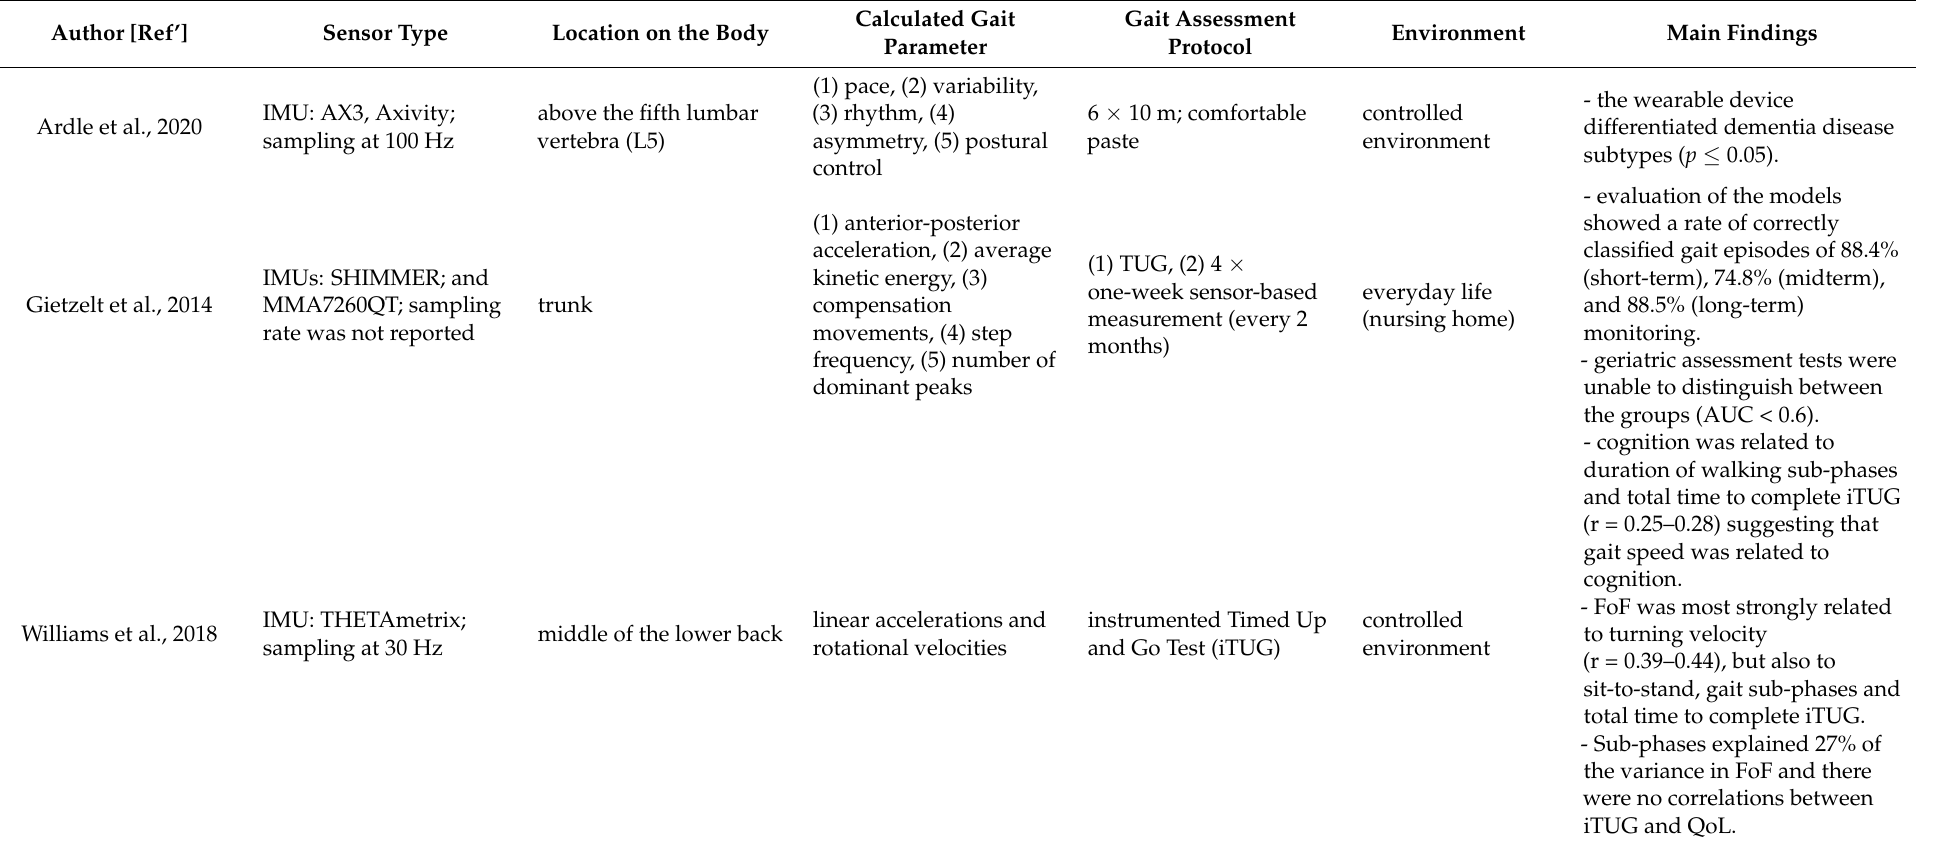
Table 2. Study parameters and outcome